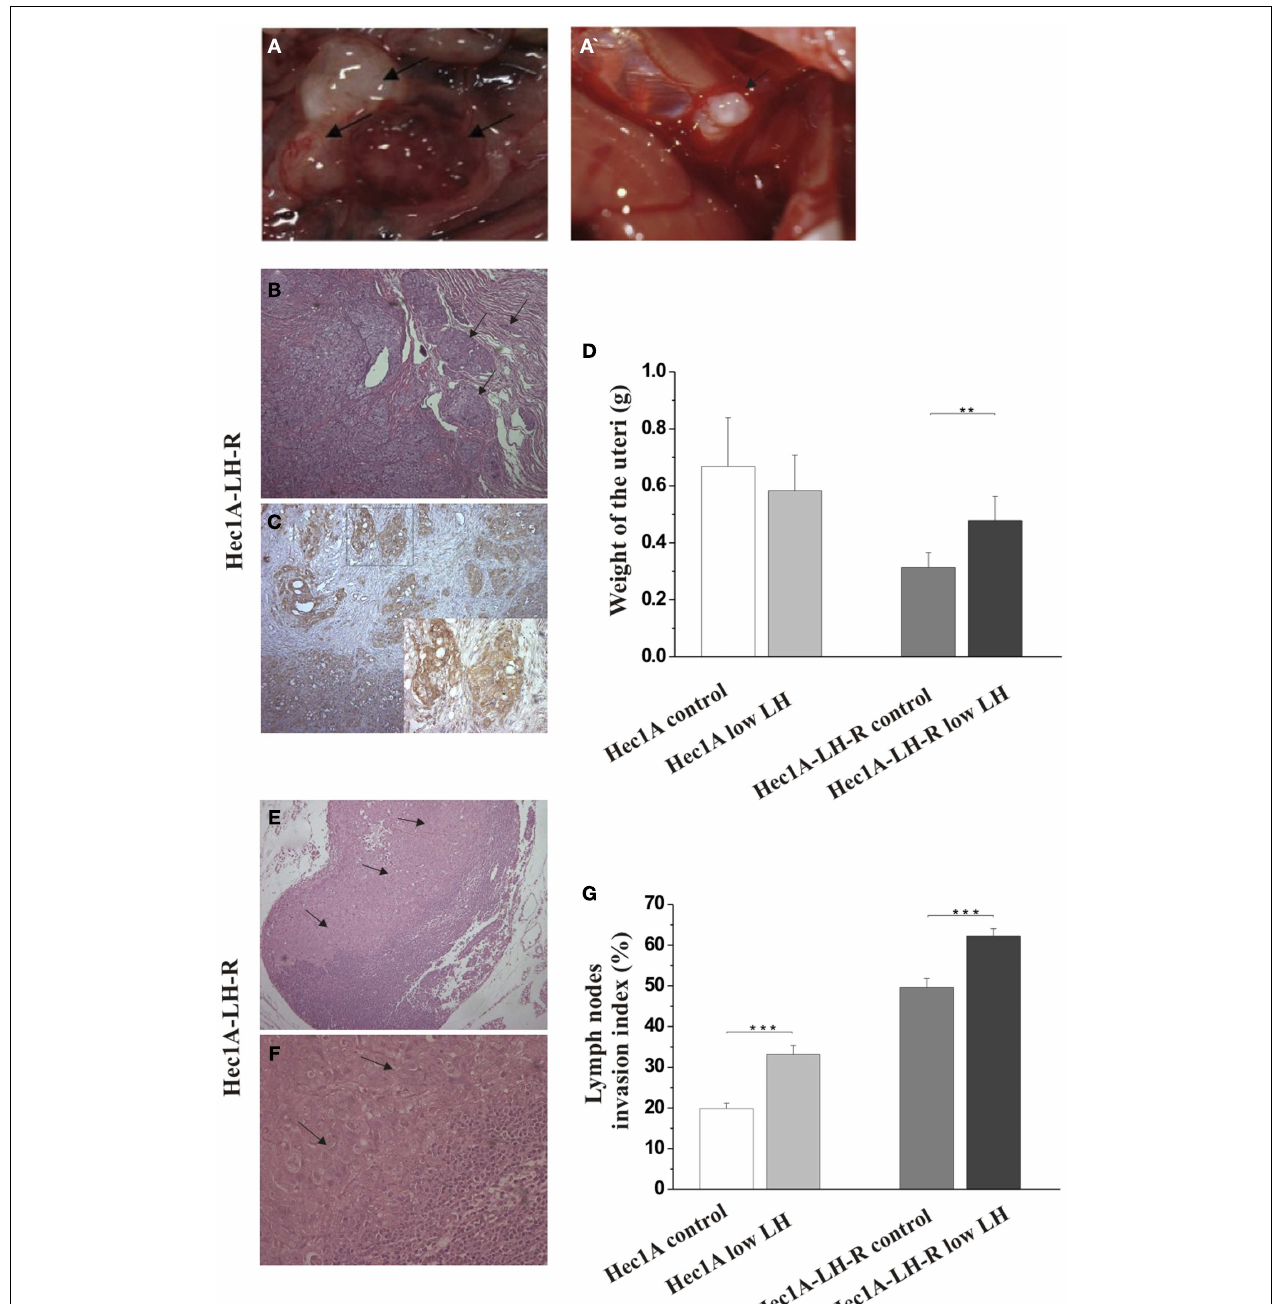
Santa Cruz (20 × magnification).The insert in (C) is a magnification of the area indicated by the square. Histograms in (D) represent the mean weight of the uteri ( ± SEM) of mice implanted with Hec1A-LH-R cells or Hec1A and treated or not with LH. Statistical analysis was performed with Student’s t test. (E) Histological analysis showed para-aortic lymph node tumor cells invasion (see arrows) (10 × magnification). (F) Magnification (40 × ) of the tumor invasion area (arrows). (G) Morphometric analysis of invasion of lymph nodes in between all the different treatments was performed and histograms reported represent the mean of the area of invasion/microscopic field ( ± SEM) of lymph nodes in between all the different